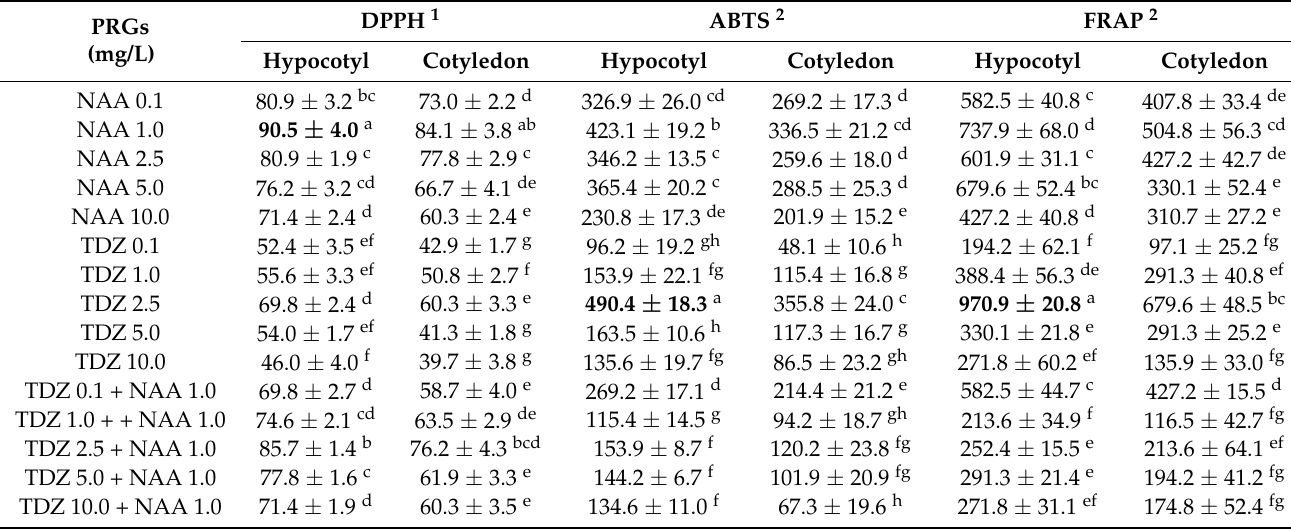
1 DPPH is expressed in % of free radical scavenging activity; 2 ABTS and FRAP are expressed in µ M Trolox-C equivalent antioxidant activity (TEAC). PRGs: plant growth regulators. Highest antioxidant activities for each assay are in bold. Values are means ± SD from three replicates. Different superscript letters indicate significant difference ( p <